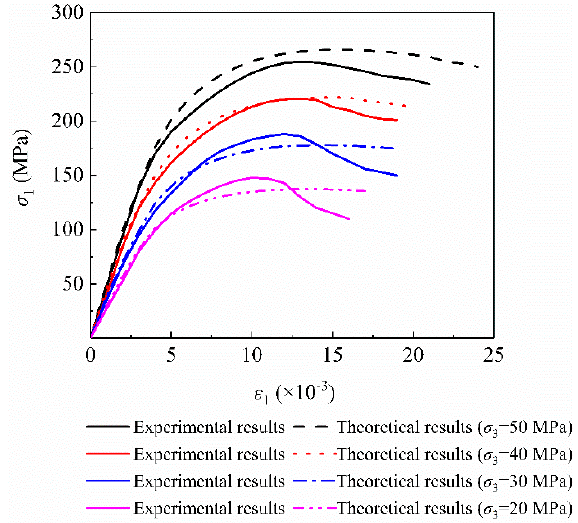
Figure 8. Theoretical and experimental stress-strain curves under different confining pressures.